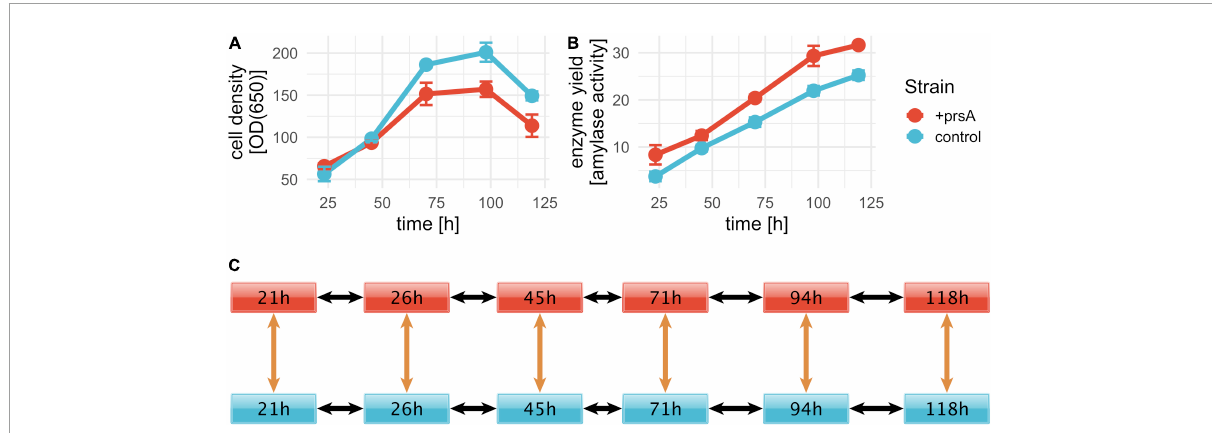
FIGURE1 AMY fed-batch fermentations. Fed-batch fermentation was conducted in triplicates for a control strain (blue) and +prsA (red). RNA-seq samples were prepared at six timepoints: 21, 26, 45, 71, 94, and 118 h after fermentation start. Cell density and enzyme yield were measured for five timepoints: 23.2, 45, 70.2, 97.8, and 119 h. (A) The average cell density per strain over fermentation time was measured in optical density (OD) at 650 nm. The error bars indicate the standard deviation. (B) With a progressing fermentation, the yield increases. The shown yield is measured in enzyme activity (see section “Strains and fed-batch fermentation”). (C) For the differential expression, we investigated the significance of differential expression between the samples at six pairwise comparisons (orange arrows) and changes in expression over time in either strain for each pair (black